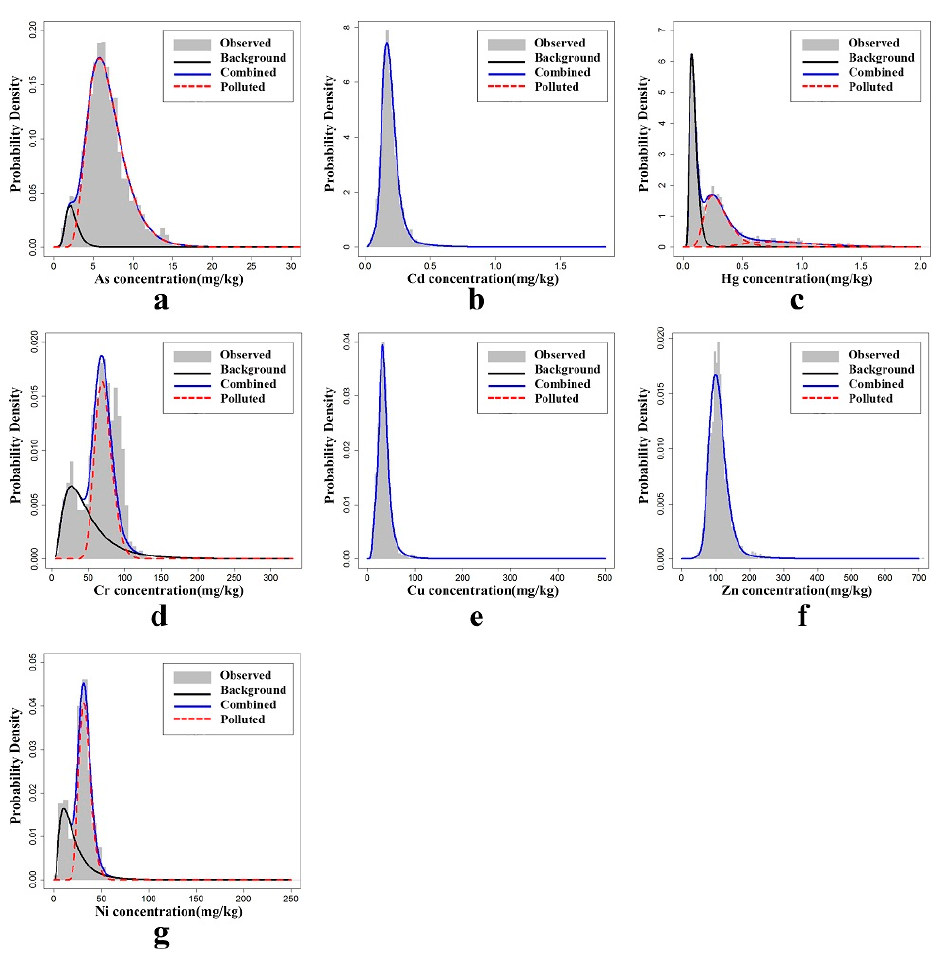
Figure 7. FMDM fit for ( a ) Cr; ( b ) Cd; ( c ) Hg; ( d ) As; ( e ) Cu; ( f ) Zn; and ( g ) Ni.